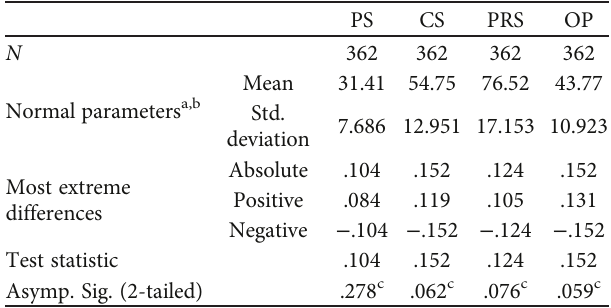
T ABLE 2: Discriminant validity. T ABLE 3: One-sample Kolmogorov – Smirnov